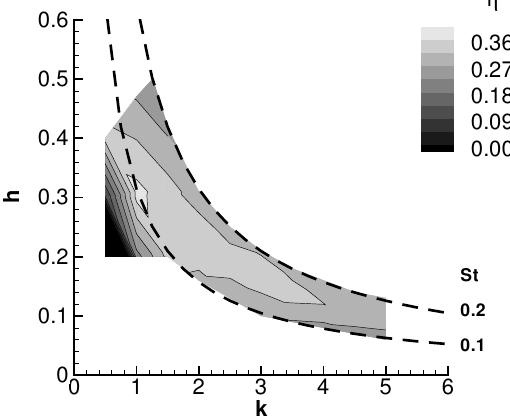
Figure 12. Propulsive efficiency with Re =